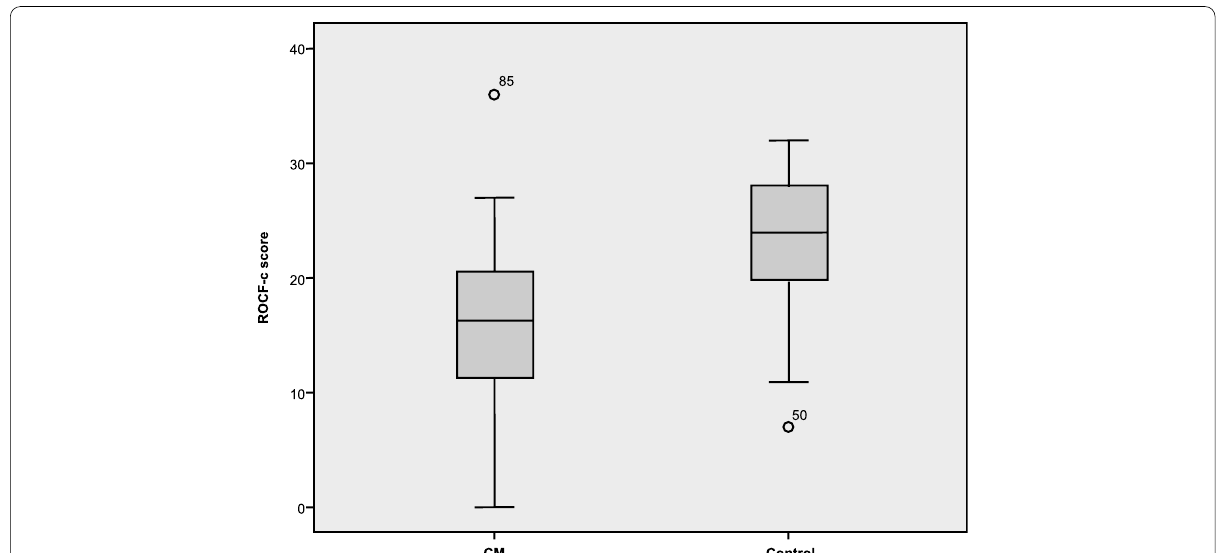
Fig. 1 Results of the ROCF copy task in the CM group and the control group. ROCF‑c: Rey‑Osterrieth Complex Figure test, copy task; CM: chronic